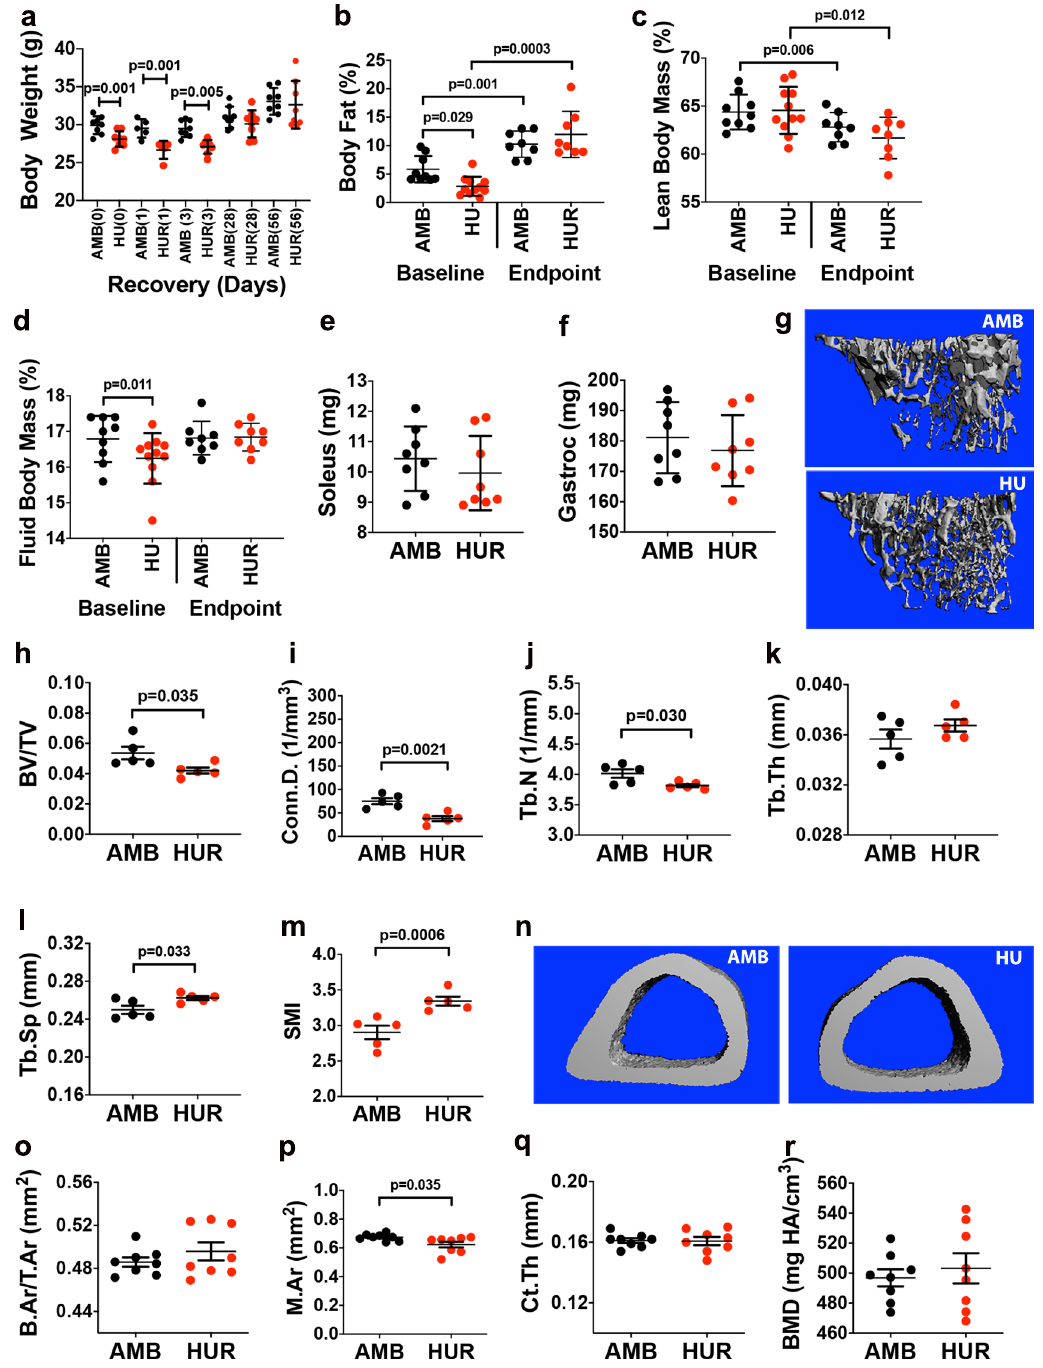
Fig. 5 HUR reverses lipodystrophy, muscle atrophy, and cortical but not trabecular bone loss. a Time course of weight gain in HUR and AMB mice wherein numbers in parenthesis are days post-HUR, which began at day 1 ( n = 6 – 8 mice/group). b – d NMR quanti fi cation of baseline and endpoint measures of body fat ( b ), lean ( c ), and fl uid mass ( d ) of AMB and HUR mice ( n = 8 mice/group). e , f Endpoint measures of soleus ( e ) and gastrocnemius ( f ) mass in AMB and HUR mice ( n = 9 – 14 mice/group). g – m Representative micro-CT images of the proximal tibia ( g ) from AMB and HUR mice and quanti fi cation of BV/TV ( h ), Conn.D. ( i ), Tb.N. ( j ), Tb.Th. ( k ), Tb.Sp. ( l ), and SMI ( m ) ( n = 8 – 10 mice/group). n – r Representative micro-CT images of the midshaft tibia ( n ) from AMB and HUR mice and quanti fi cation of B.Ar/T.Ar ( o ), M.Ar. ( p ), Ct.Th. ( q ), and BMD ( r ) ( n = 8 – 10 mice/group). Data are mean ± SD. P -values in a , e , f , h – m , and o – r are by Student ’ s t -test (AMB vs. HU mice at each time point) and in b – d by one-way ANOVA with Tukey post hoc bone loss was progressive in response to prolonged HU, which microgravity exposure in astronauts. This approach revealed that deviates from an earlier study showing that muscle atrophy and muscle atrophy observed after 8wk remained stable by 14wk of bone loss in HU are interrelated 66 . We did not quantify levels of HU, which is consistent with other studies showing brief intervals of HU induces rapid onset of muscle wasting 63 – 65 . In contrast, irisin, a muscle myokine with bone anabolic activity 67 – 69 , which is